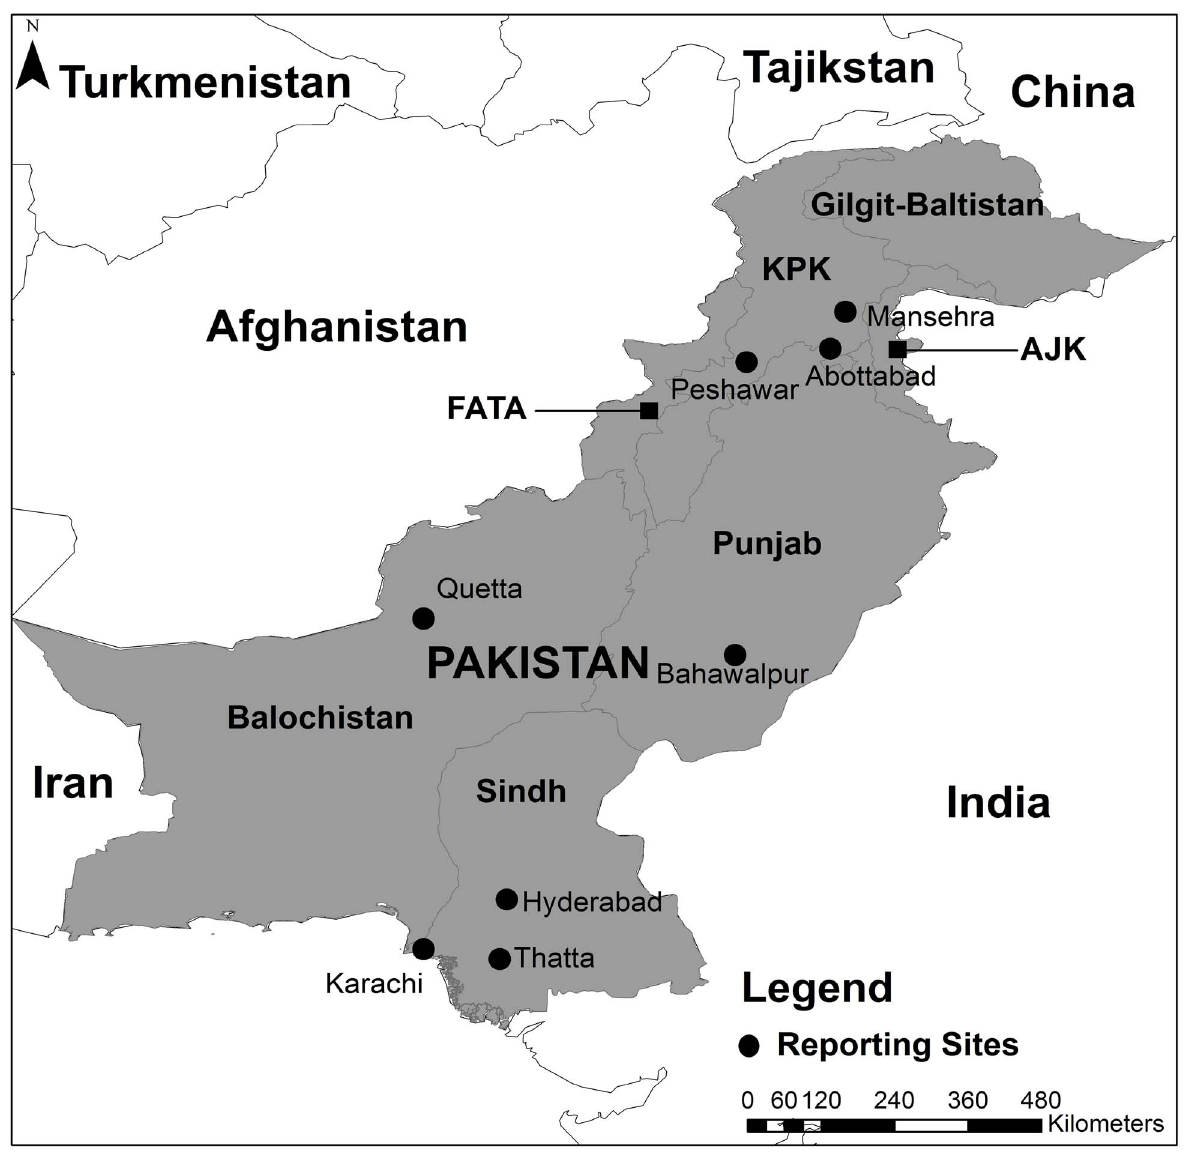
Figure 1. Phone based screening for dog-bites and rabies was established at nine tertiary hospital emergency rooms across Pakistan, including 2 in Karachi, February 2009–February